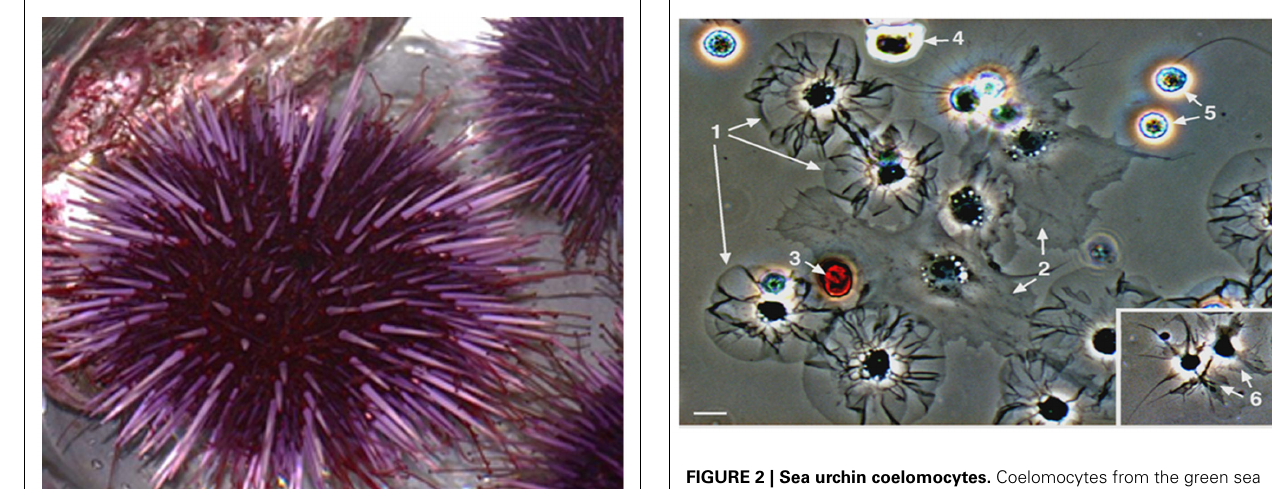
FIGURE 2 | Sea urchin coelomocytes. Coelomocytes from the green sea urchin, Strongylocentrotus droebachiensis , were settled onto a glass coverslip and imaged live. Cell types that are typical of echinoids include discoidal phagocytes (1), polygonal phagocytes (2), red spherule cells (3), colorless spherule cells (4), vibratile cells (5; the lower cell has lost the prominent flagellum that is present in the upper cell), and small phagocytes (6, inset). Bar = 10 μ m.This is Figure 2 from Smith et al. (2010), reproduced with permission from Landes Bioscience and Springer Science + Business Media.